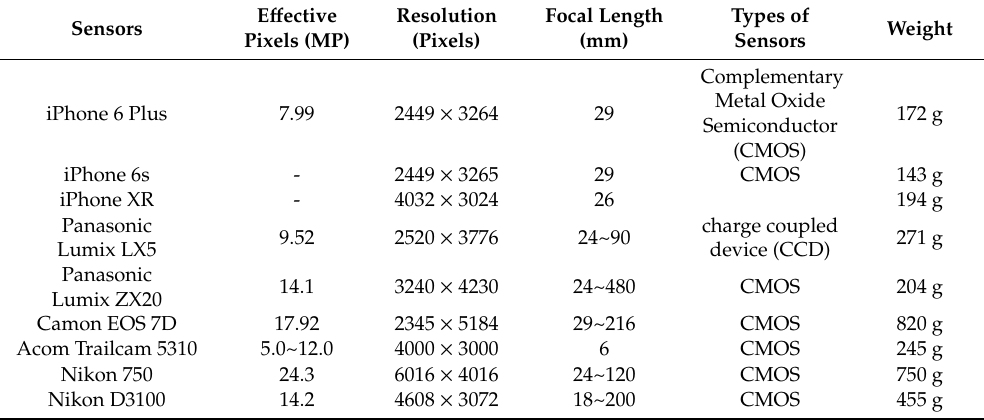
Table 3. The related technical specifications of sensors for image